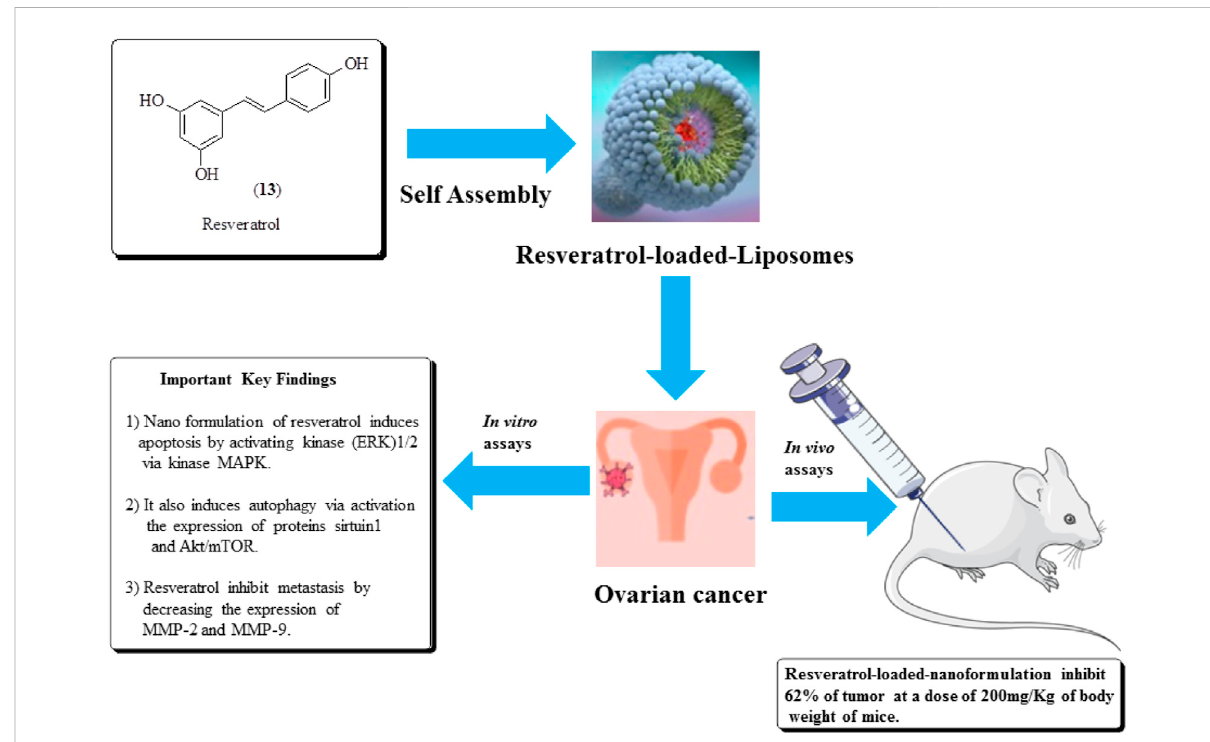
FIGURE 16 Structureofresveratrolanditsanticancerpotentialalongwithitsmechanisticinsights.Resveratrol-loadedliposomeswereassessedforovarian cancer treatment using in vitro and in vivo